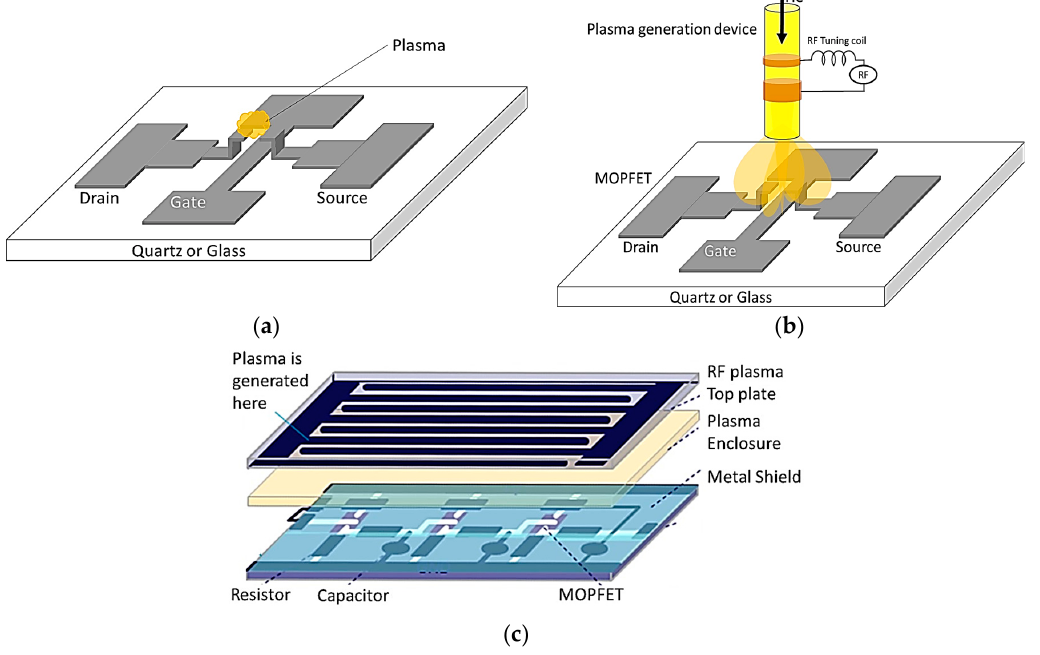
Figure 8. Schematics of: ( a ) self-generating plasma MOPFET; and ( b ) separate medium device. ( c ) Schematic of a separate-medium integrated circuit with MPDs [32].